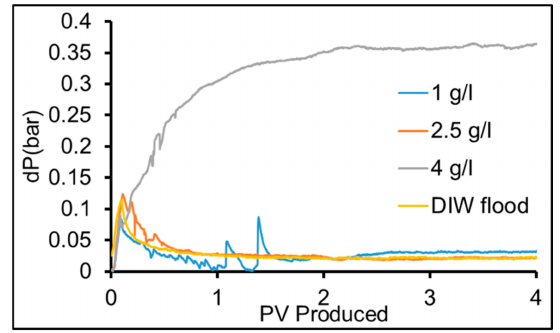
Figure 8. Variation of the drop across the core (dP) during post flush with DIW after saturation of the core with MPTMS stabilized nanofluids at different NP concentrations of NP (Experiments